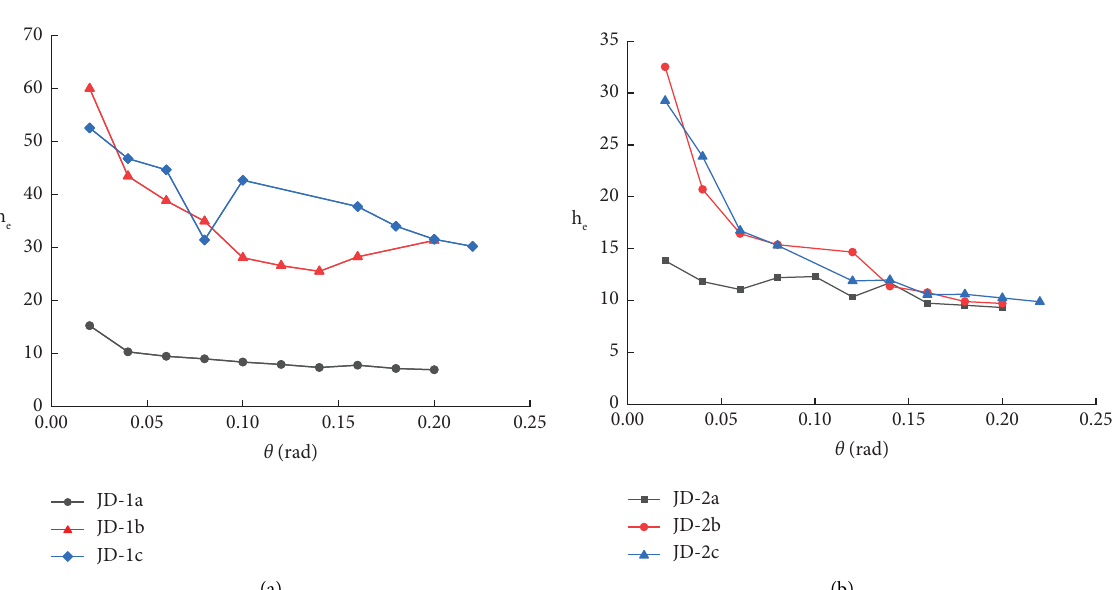
Figure 14: Viscous damping of continuous tenon joint: (a) unreinforced nodes. (b) Reinforcement